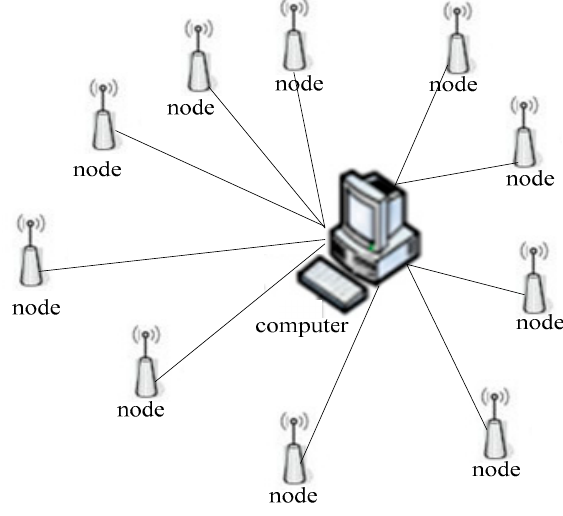
Figure 2. Sensor communication network node distribution